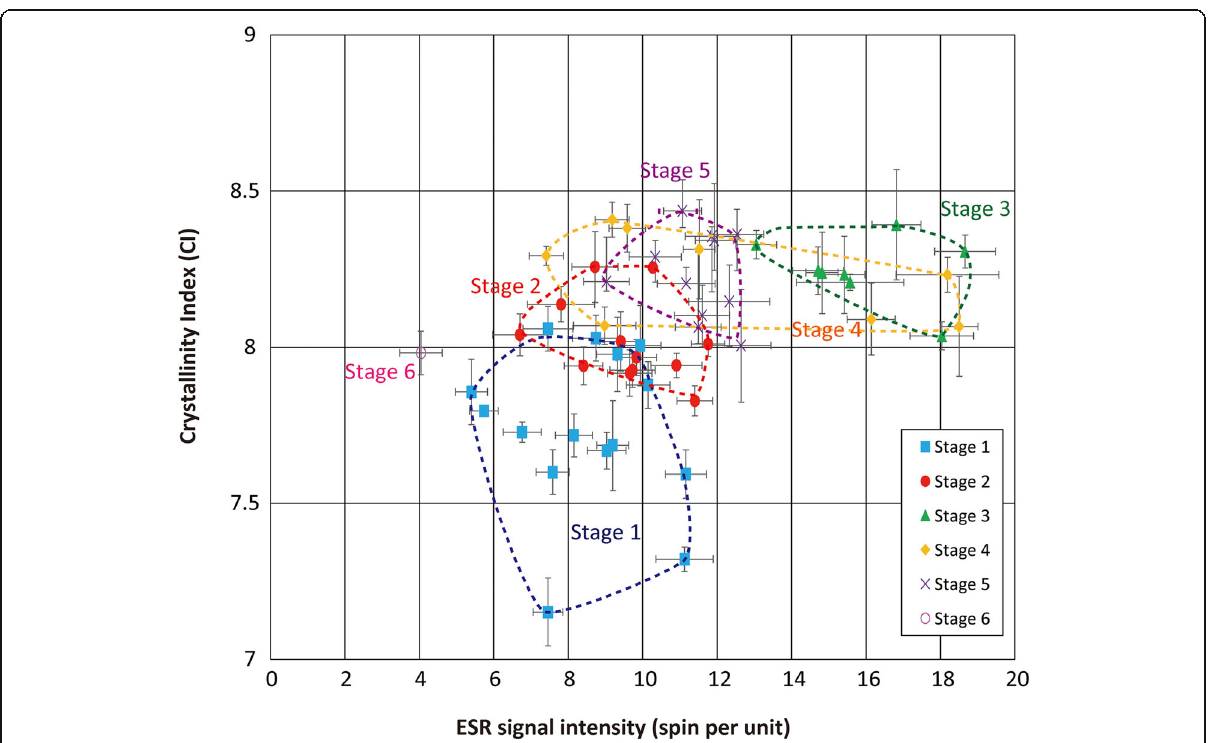
Fig. 8 ESR vs. CI plot. The relationship between the ESR signal intensity and CI of quartz for the fine sand fraction of fluvial sandstone in the Aertashi section. The stages are divided on the basis of the temporal variations of the ESR signal intensity and